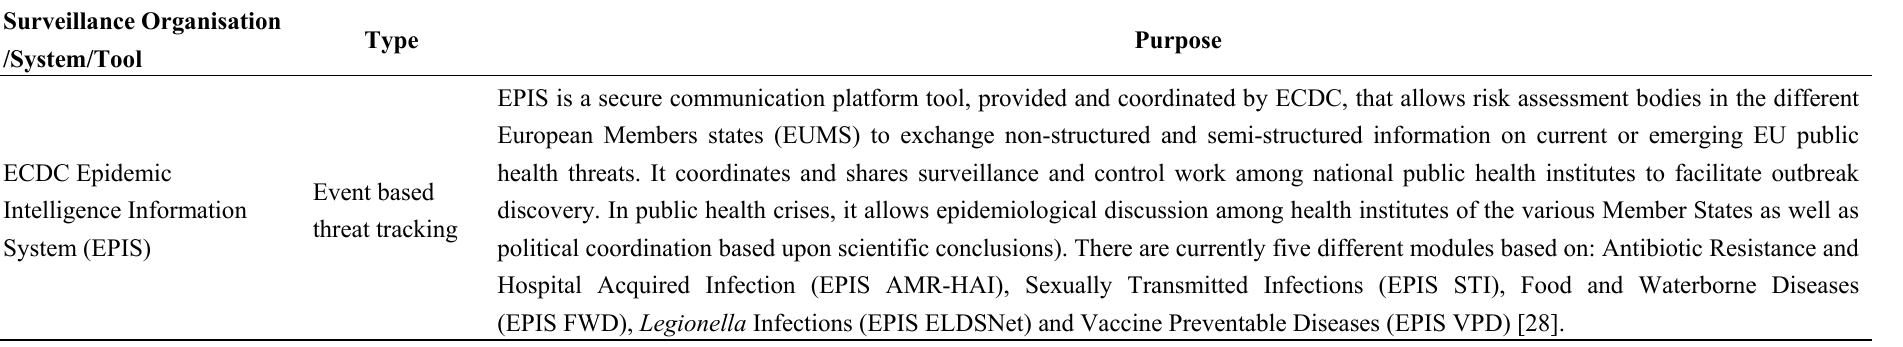
Table 2. Surveillance systems, tracking tools, communication systems, information exchange and outputs within